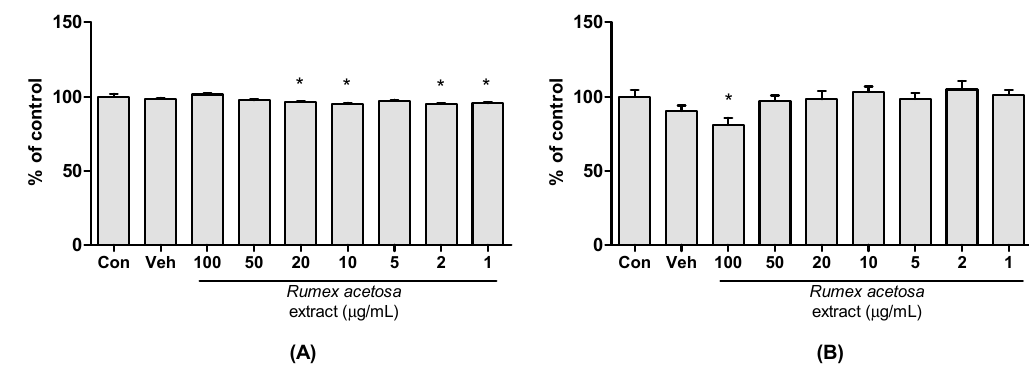
Figure 1. Cytotoxicity of R. acetosa extract in ( A ) Caco-2 cells and ( B ) HEK293 cells ( n = 6). Con—media only treated control; Veh—vehicle treated group; *— p < 0.05 compared to media only treated control group.